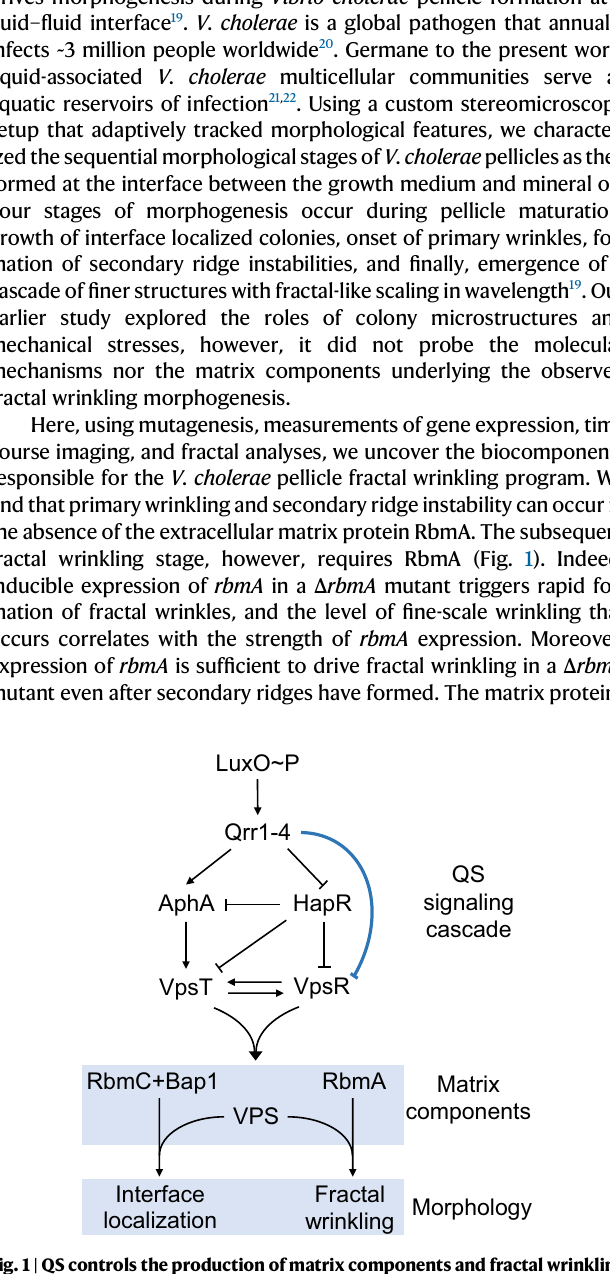
Fig.1|QScontrolstheproductionofmatrixcomponentsandfractalwrinkling during V.cholerae pelliclemorphogenesis. Asimpli fi edschemeofthe